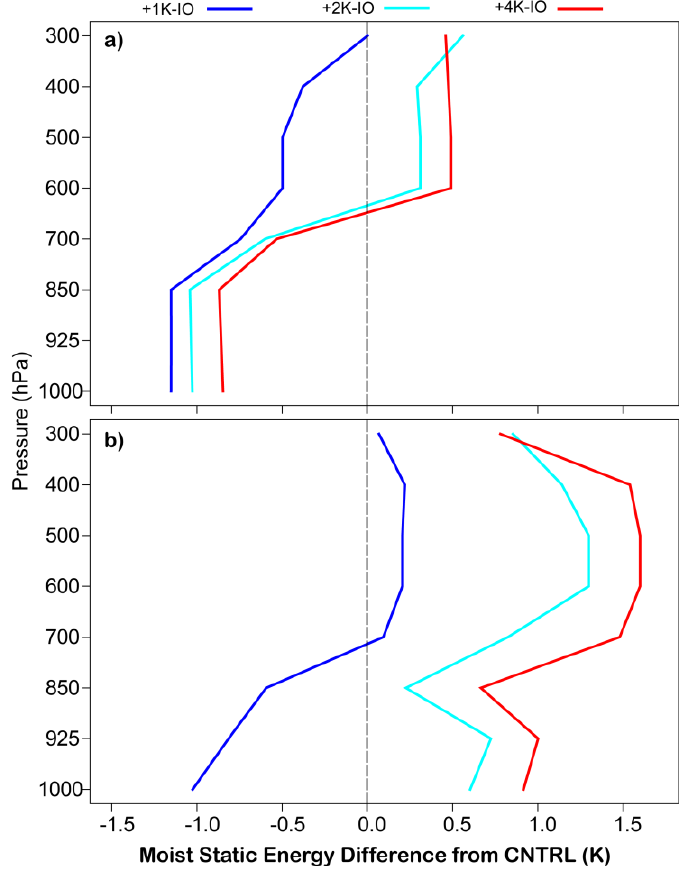
Figure 14. Vertical profiles of moist static energy (MSE) for warm Indian Ocean experiments. ( a ) Deviations from CNTRL of moist static energy for the Blue Nile catchment (7°–11°N, 36°–40°E) for +1K (blue), +2K (cyan), and +4K (red) Indian Ocean simulations; ( b ) Same as (a) except for MSE calculated for Northern Ethiopia (11°–14°N, 38°–40°E). MSE is given in units of K by normalizing it by the specific heat of air at constant pressure. See Table 1 for description of